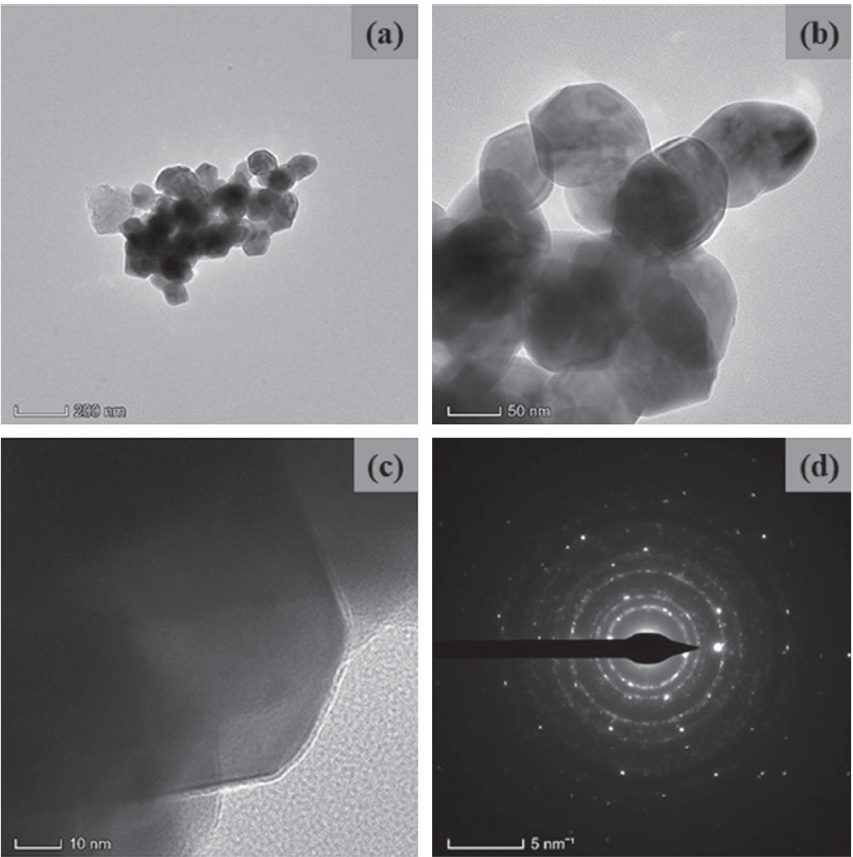
Figure 3: TEM images (a-c) and SAED (d) pattern of